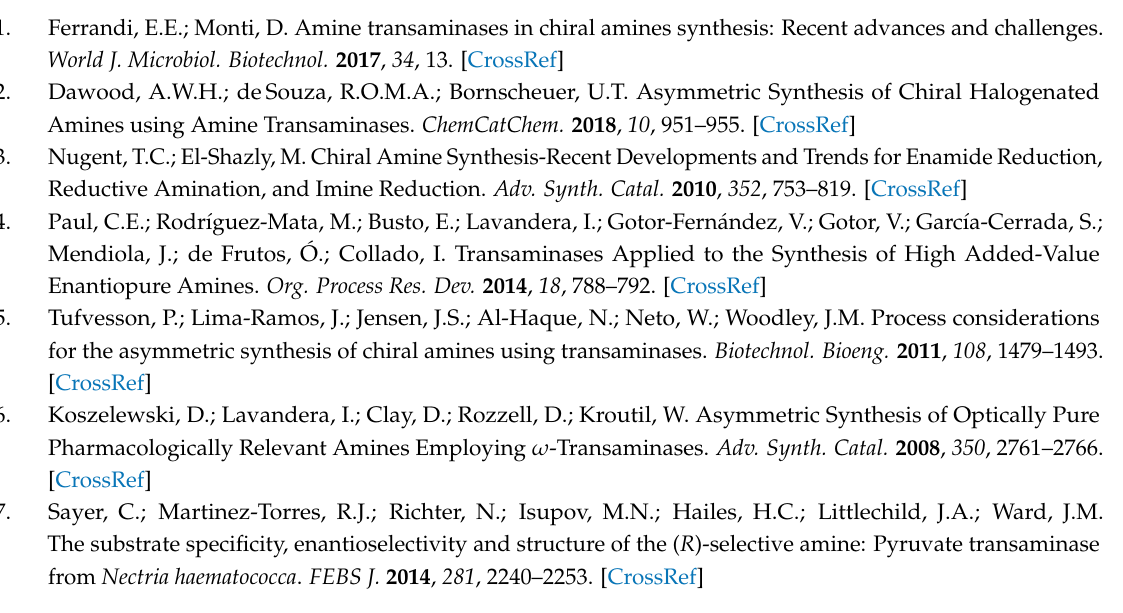
Supplementary Materials: The following are available online. Figure S1: Mutual information network (A) and distance network (B) of AT-ATA provided by MISTIC, Figure S2: Circos representation of the AT-ATA protein family (PF01063), Figure S3: Alanine scanning of the eight amino acid residues (H76, F115, E117, L118, N181, W184, T274, and T275), Figure S4: The stabilized mutants screened from the saturation mutation library of the site L118, Figure S5: Thermal unfolding of wild-type AT-ATA and its mutants were monitored by DSF, Table S1: Primers used for alanine scanning and saturation mutagenesis, Table S2: Stability comparison of wild-type and stabilized single variants by three rational